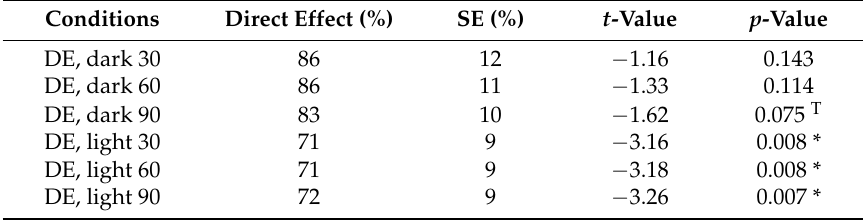
Table 4. Comparison between direct effects for 30, 60 and 90 pointing movements and prismatic power, before adaptation, in dark and bright laboratory. One-sided t -test against 100 percent (=optical power of the